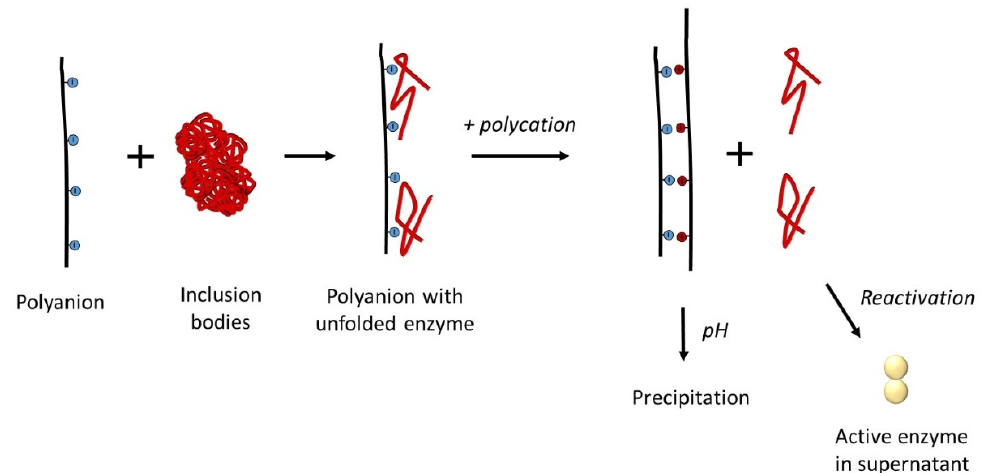
Figure 2. Reactivation of enzymes during their release into solution by the interaction of oppositely charged polyelectrolytes.